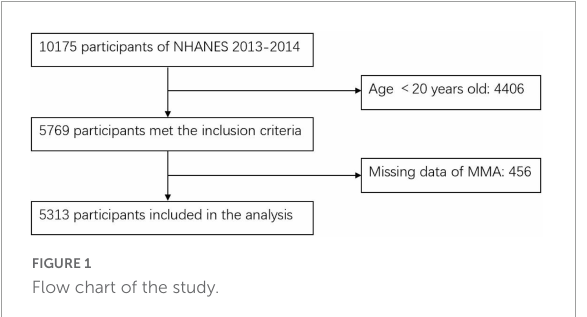
FIGURE1 Flow chart of the